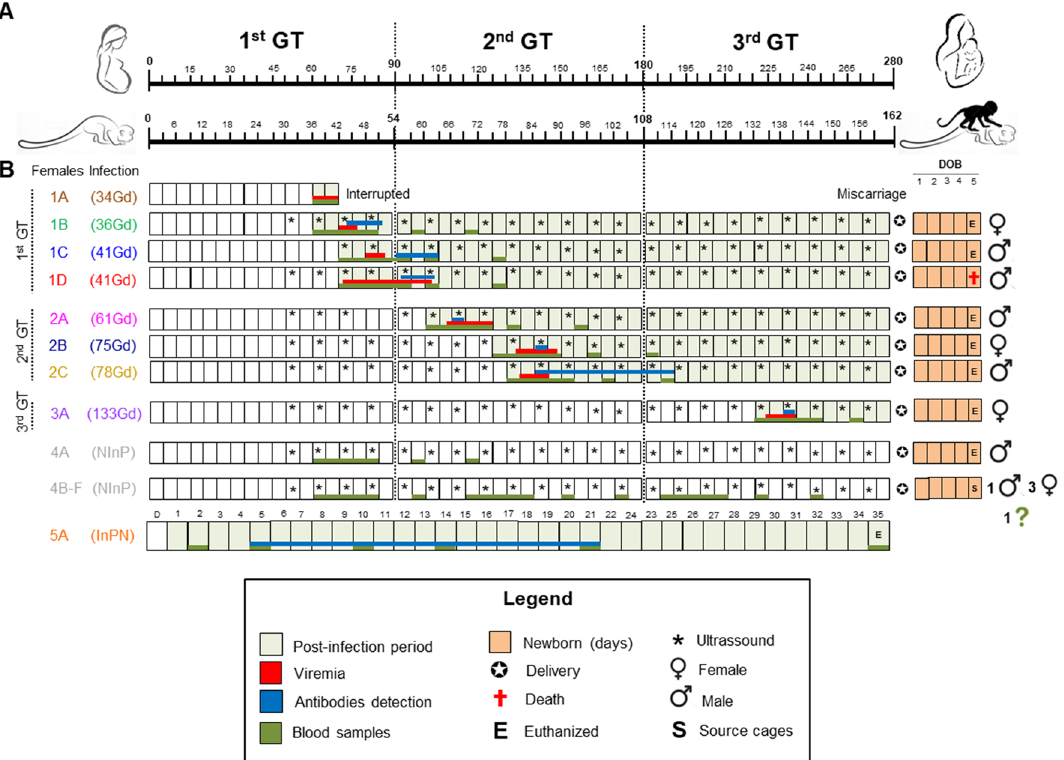
Figure 1. Experimental ZIKV infection in pregnant squirrel monkeys. Design of study, sex and outcome of neonates. ( A ) Comparison in days of the gestational periods between humans and squirrel monkeys. ( B ) Timeline of the five groups in the experiment: ZIKV-infected pregnant females in the 1st gestational third (GT), 2nd GT and 3rd GT, noninfected pregnant (NInP) group, and infected nonpregnant (InPN) group. The pregnant female squirrel monkeys were infected with ZIKV on the 34th, 36th, 41st, 61st, 75th, 78th and 133rd days (Gd) of the gestational period. The 1A animal (1st GT) miscarried; the other animals had normal gestations up to